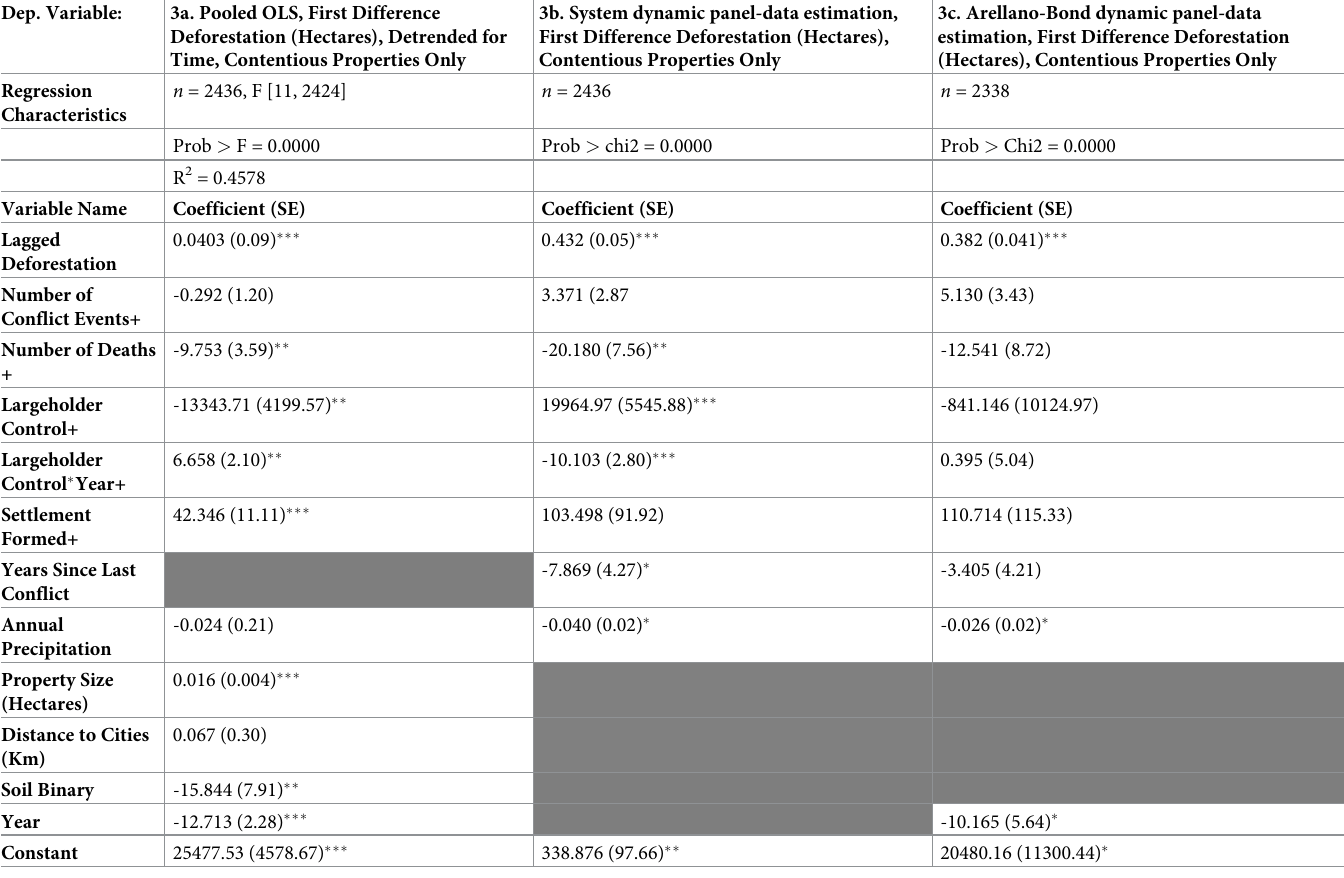
Table 2. H2 regression results. See S7 Table for details on Table 2B and S8 Table for details on Table 2C. Dep.